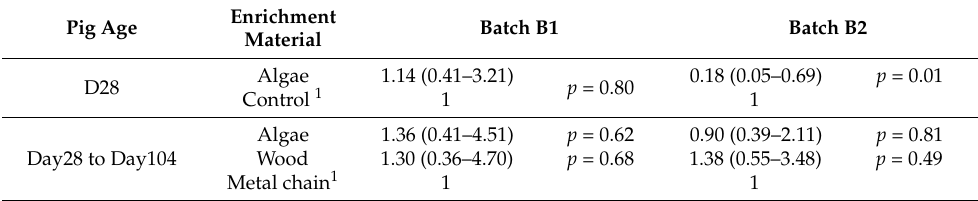
Table 3. Risk of being injured (odds ratio (confidence interval at 95%)) by Day 28 (D28) at weaning ( n = 228 pigs in batch 1 and n = 215 pigs in batch 2) and during the nursery and finishing periods, D28 to D104 ( n = 228 pigs in batch 1 and n = 215 pigs in batch 2), according to the enrichment material. The 95% confidence intervals were calculated from the logistic model for the mixed data, taking into account repeated measures during the post-weaning and finishing